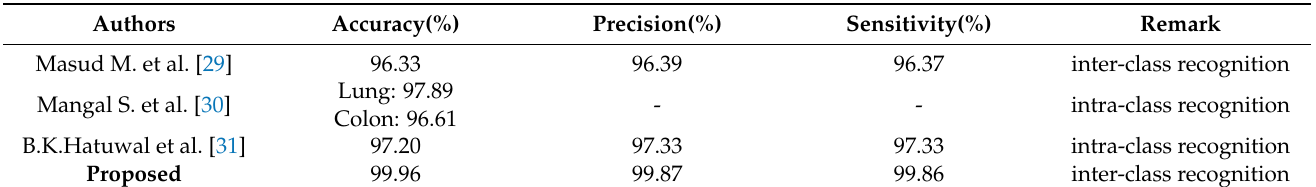
Table 4. Performance of the CroReLU method compared with existing works on the LC25000 dataset